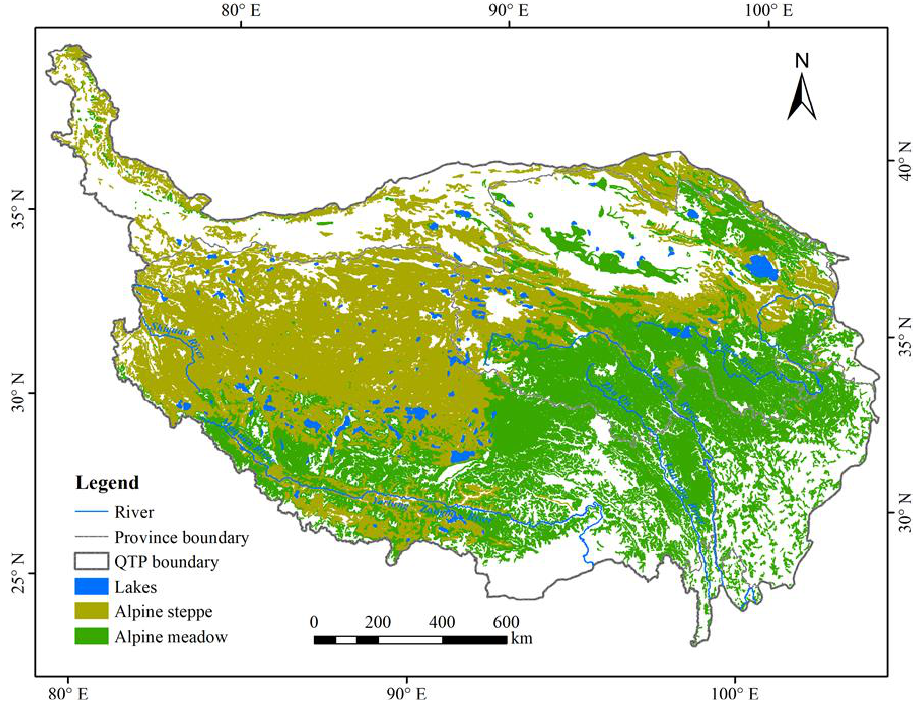
Figure 2. Spatial distribution map of alpine meadow and alpine steppe along the Qinghai-Tibet Plateau as adapted from the 1:1,000,000 vegetation map.